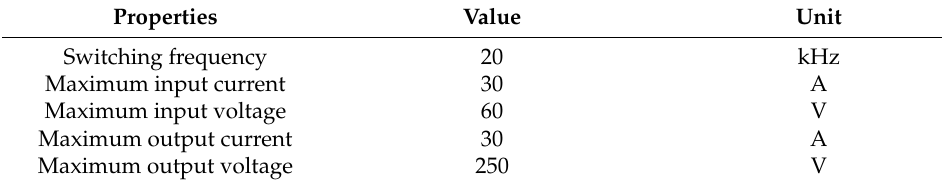
Table 3. TEP-192 Details.